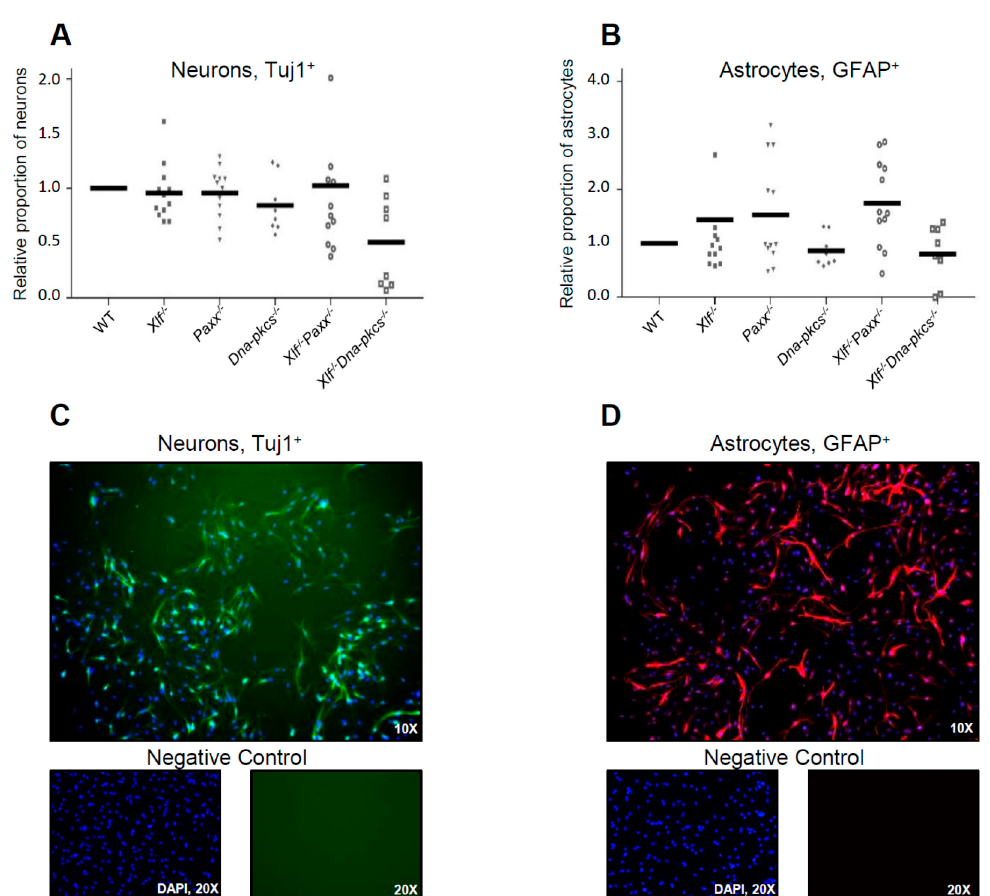
Figure 3. Differentiation of neural progenitors to neurons and astrocytes. ( A ) Proportion of neuron-specific class III beta- tubulin (Tuj1 + ) early neurons and ( B ) Glial fibrillary acidic protein (GFAP + ) astrocytes following five days of differentiation from NSPCs of indicated genotypes and normalized by WT controls. Average of two replicates per clone, where two clones represent an independent mouse embryo, and three independent experiments ( n = 12). ( C , D ) Examples of the immunostaining using antibodies against Tuj1 and GFAP, as indicated. Tuj1 + cells are in green (C). GFAP + cells are in red ( D ). DNA was visualized with 4 ′ ,6-diamidino-2-phenylindole (DAPI, blue). Negative controls were performed without adding the primary antibodies (bottom).